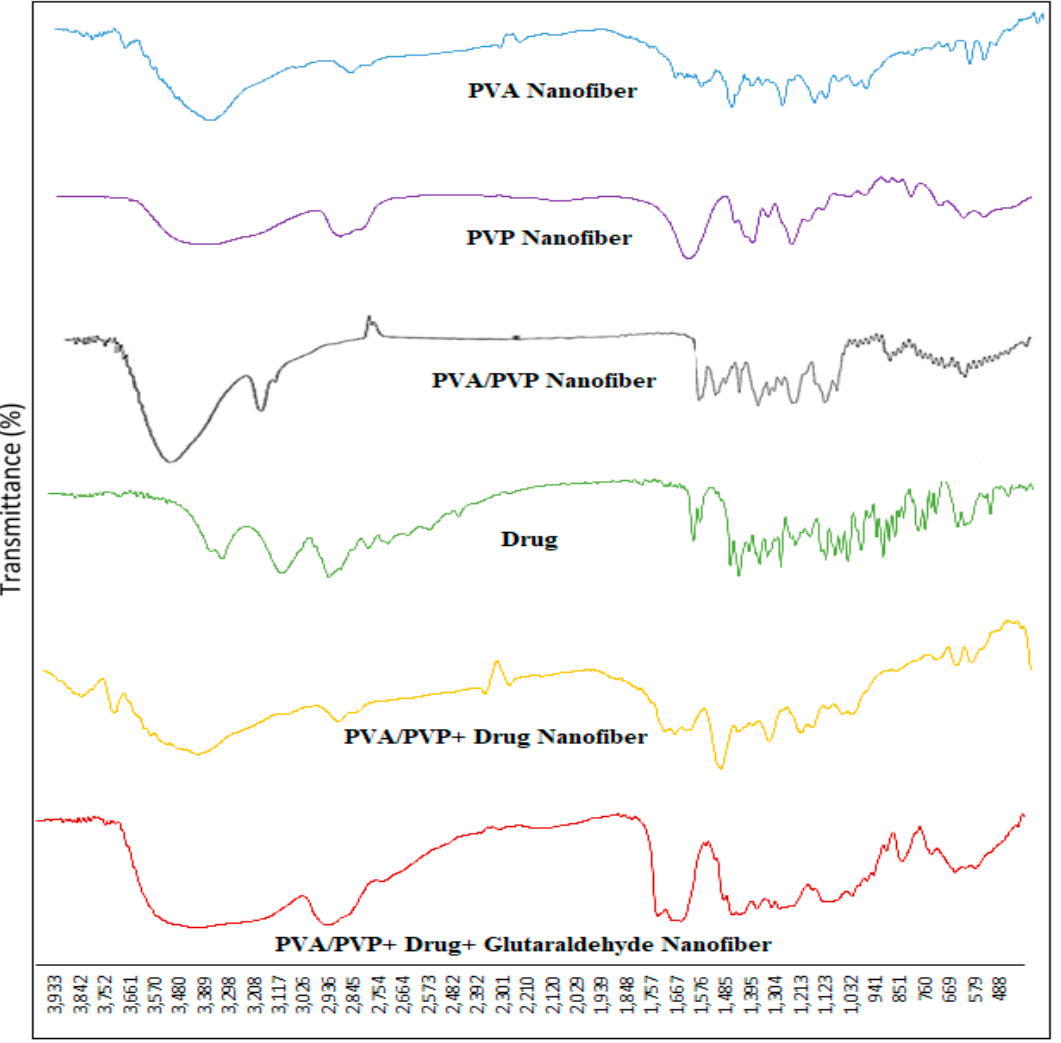
Figure 7. Fourier transform infrared (FT-IR) spectra of PVA nanofibers, PVP nanofibers, PVA/PVP nanofibers, Bup, Bup/PVP/PVA nanofibers and cross-linked Bup/PVP/PVA nanofibers.